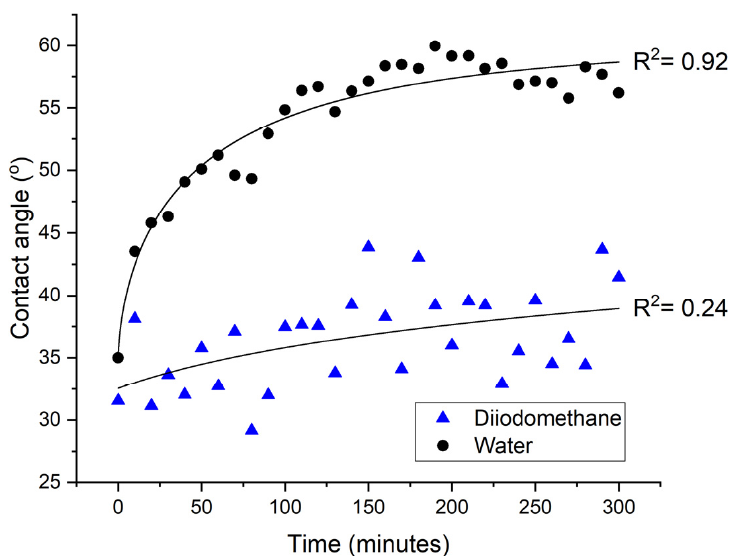
Figure 12. Ageing of GFPA6 surface represented by water and diiodomethane contact angles on the same locations after μ Plasma modification.